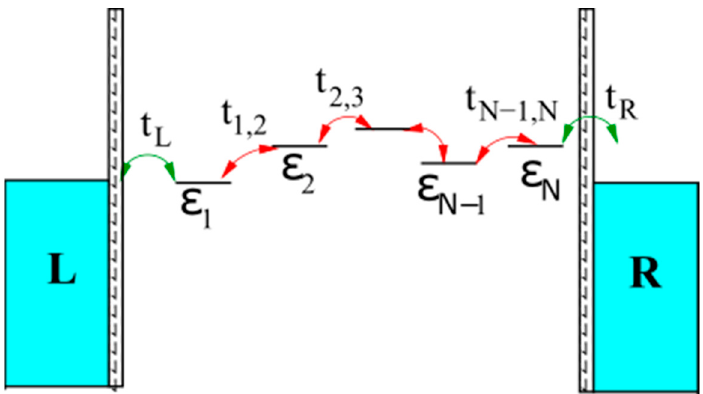
Figure 2. Schematic representation of the bridge model with N sites of energy ε 1, ε 2 ... ε N coupled through hoppings t 1,2 , t 2,3 , ... . t N-1,N and bridging the left and right electrodes. Reprinted figure from